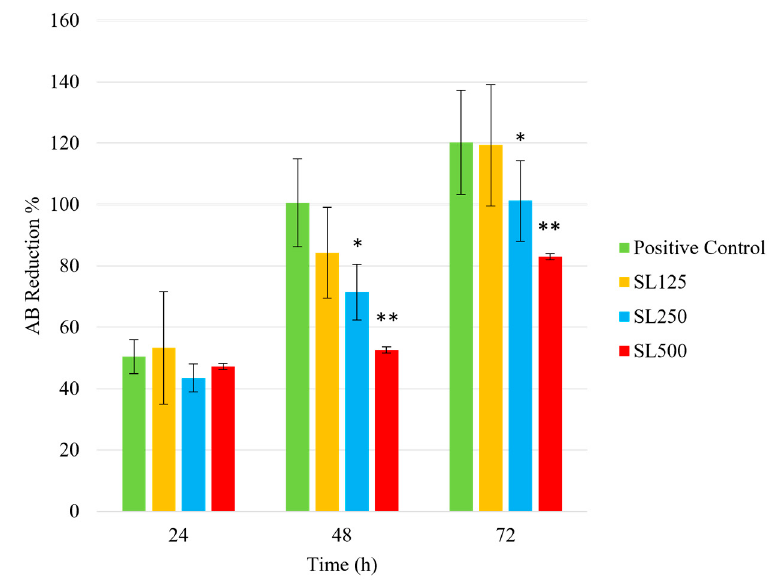
Figure 11. Cytotoxicity effects of SL at different concentrations using the AB assay, n = 5. * statistically significant difference from positive control ( p < 0.05); ** statistically significant difference from positive control ( p < 0.01).